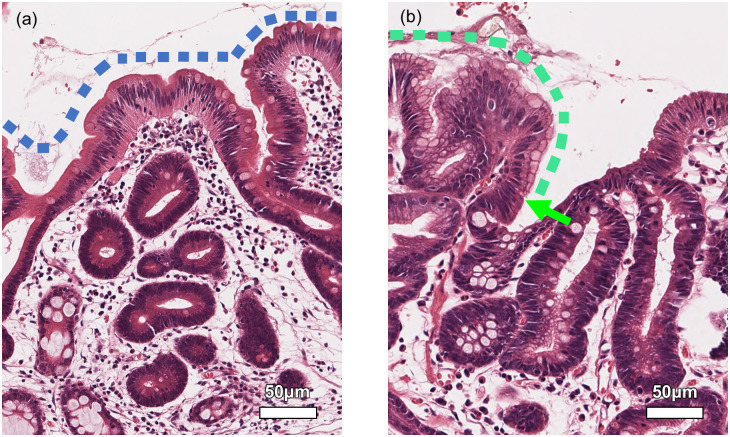
Definition of non-neoplastic epithelium (NE).(a) Columnar epithelium within GC has no atypia (blue dot line). These cells are not defined as NE, because they do not have clear front with surrounding cancer cells. They are thought to be epithelium with low-grade atypia or surface differentiation. (b) Columnar epithelium within GC has no atypia (green dot line). These cells are defined as NE, because they have clear front with surrounding cancer cells (green arrow). (a, b, hematoxylin-eosin, original magnification ×200; scale bar = 50 μm).